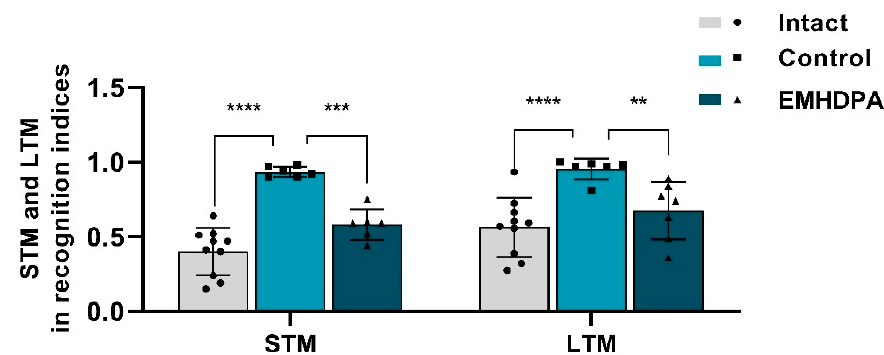
Figure 10. The effect of the studied drugs on the short-term memory (STM) and long-term memory (LTM) recognition indices in rats on the 10th day after meningitis simulation. Note: **— p < 0.01; ***— p < 0.001; ****— p < 0.0001; 1—intact group; 2—control group; 3—group administered with EMHDPA 25 mg/kg.